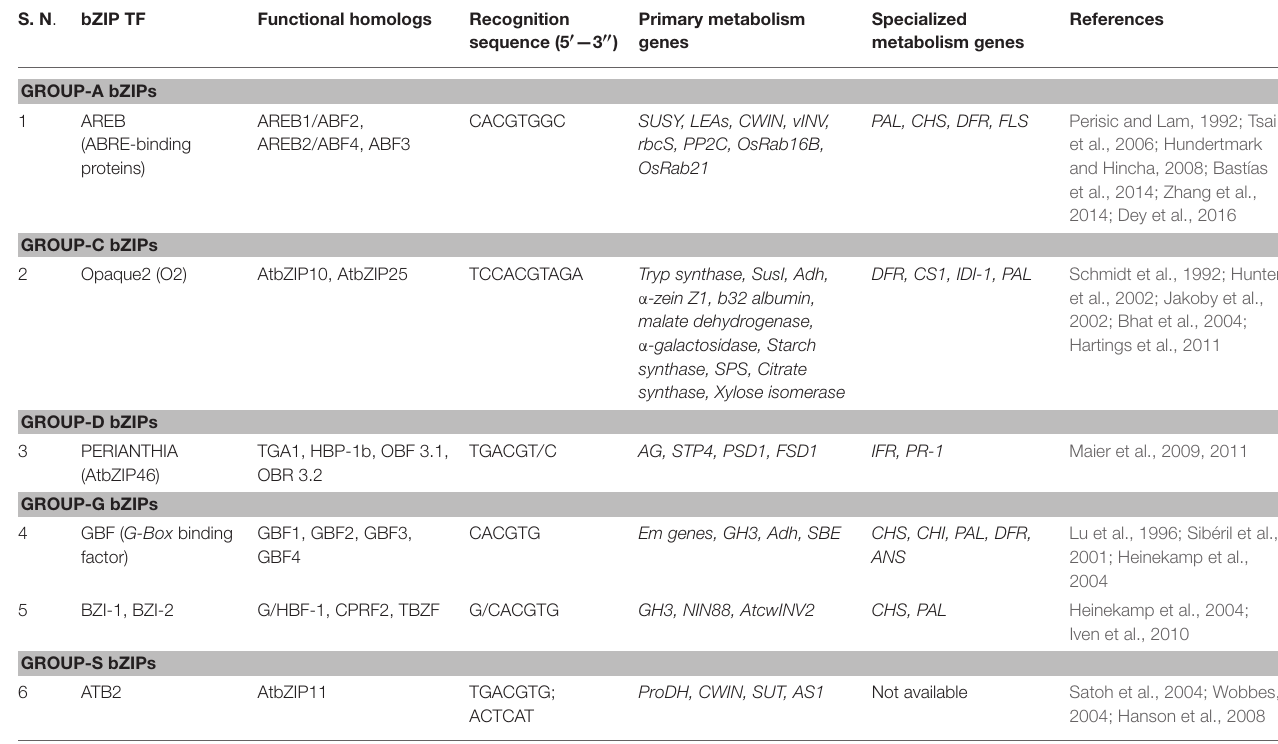
TABLE 2 | bZIP TF family in regulating primary and specialized metabolism genes